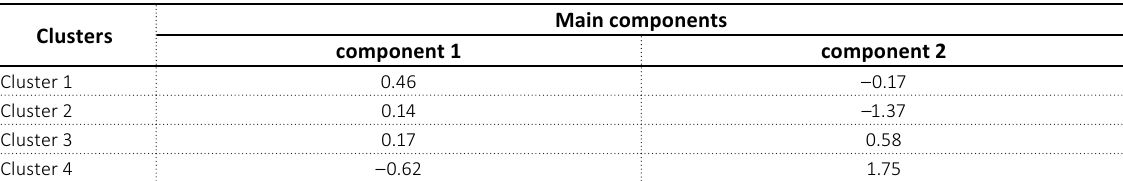
Table 11. Average values of the major components by clusters